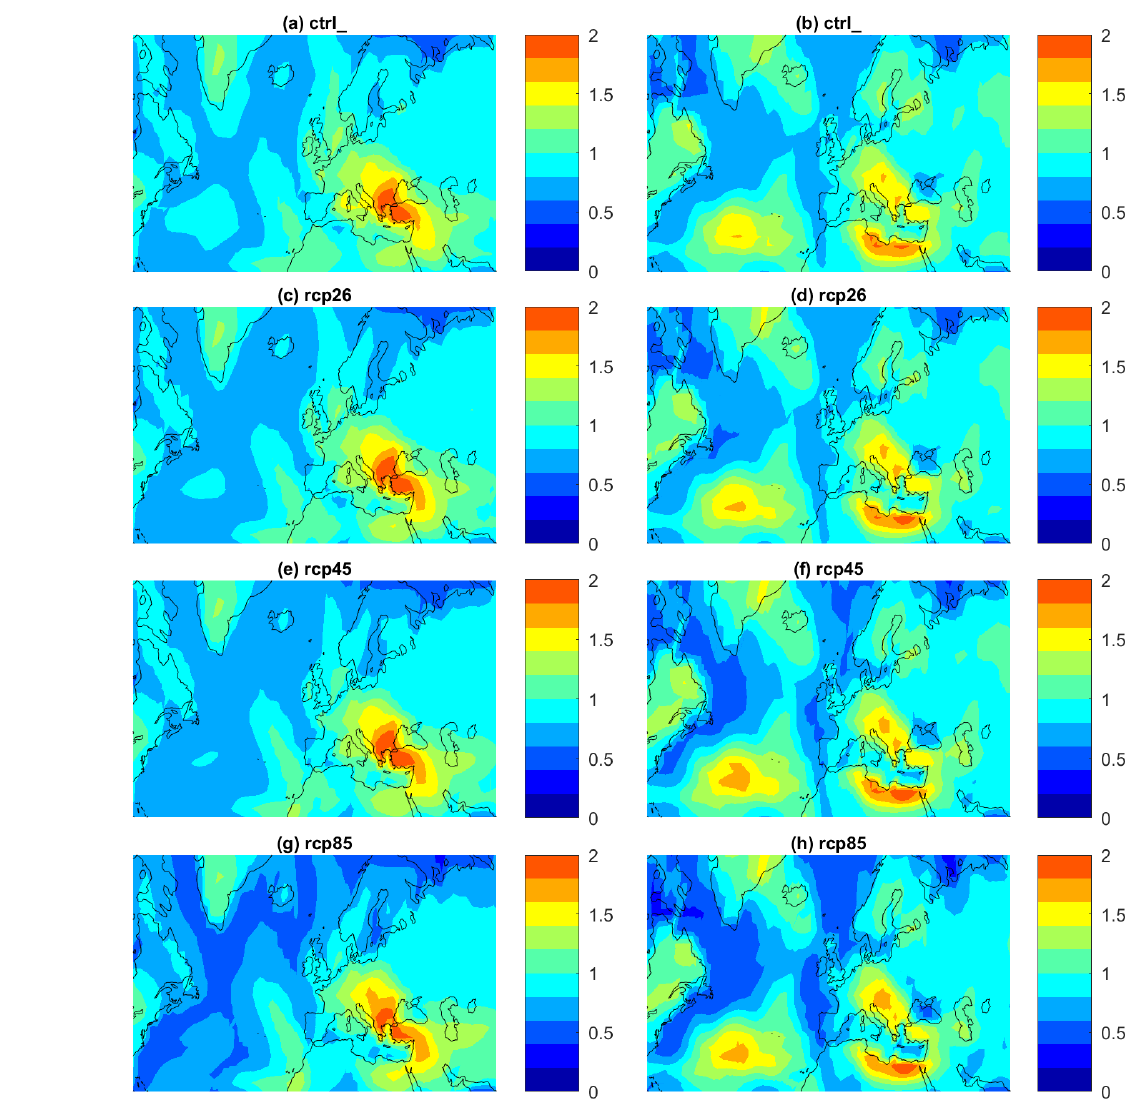
Figure B4. The figure shows 2m temperature uncertainty in PlaSim analogues: root mean squared difference in standardized 2m temperature (standard deviations) between analogues and cluster centroids for cluster 1 (a, c, e, g) and cluster 2 (b, d, f, h) . (a, b) Control run. (c, d) RCP2.6 run. (e, f) RCP4.5 run. (g, h) RCP8.5